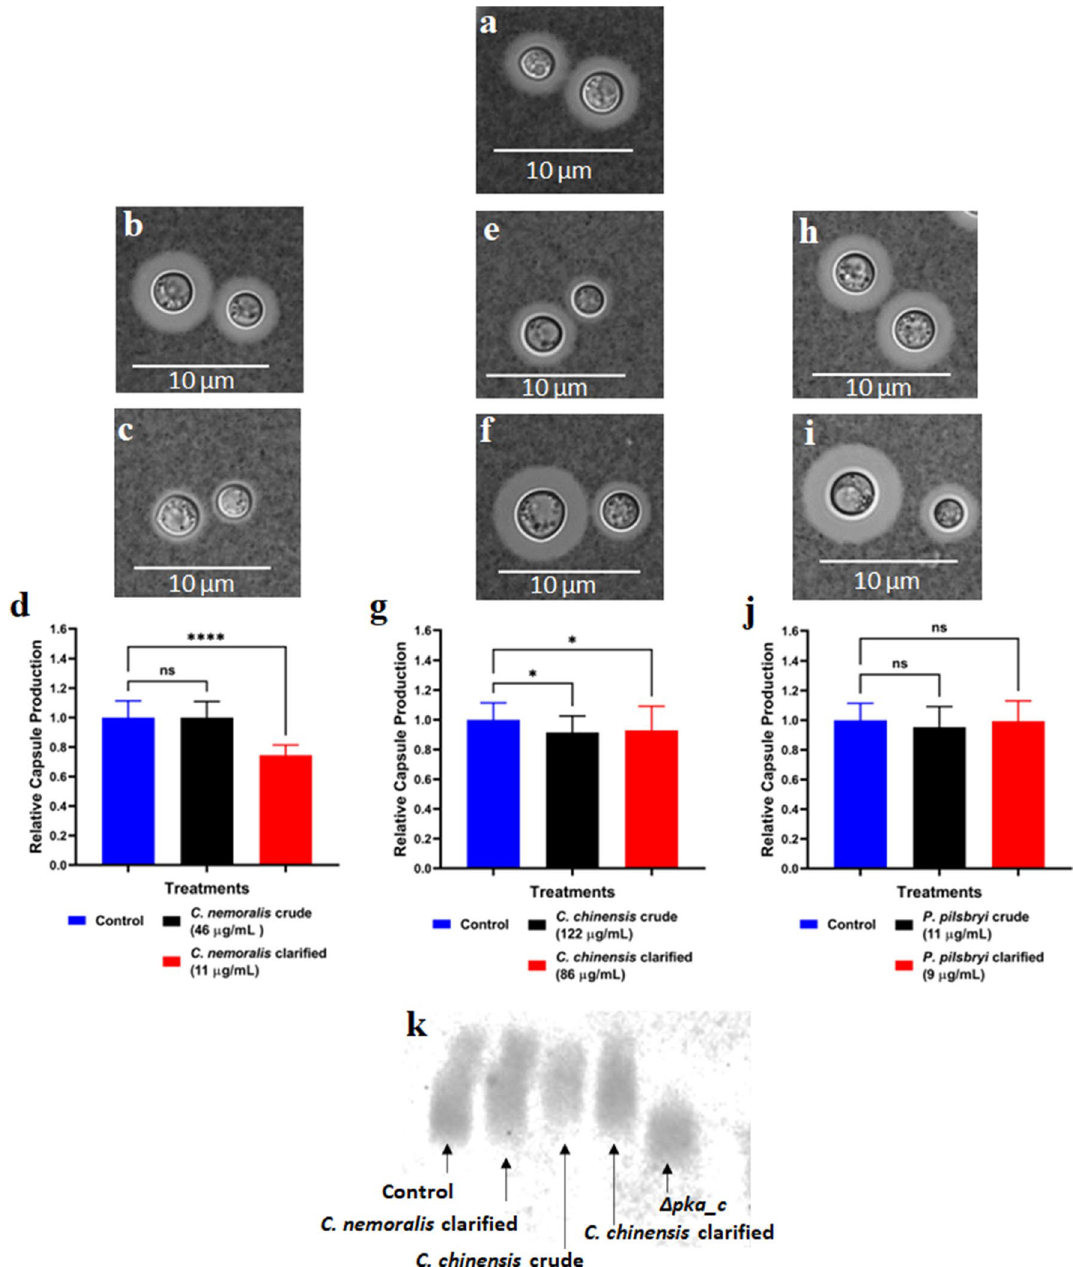
Figure 4. Representative capsule production of C. neoformans in presence of mollusk extracts at 37 °C. ( a ) Control (LIM and C. neoformans H99 only); ( b ) and ( c ) Effect of crude (46 µg/mL) and clarified (11 µg/mL) extracts from C. nemoralis , respectively; ( e ) and ( f ) Effect of crude (122 µg/mL) and clarified (86 µg/mL) extracts from C. chinensis , respectively and ( h ) and ( i ) Effect of crude (11 µg/mL) and clarified (9 µg/mL) extracts from P. pilsbryi , respectively. ( d ), ( g ) and ( j ) Statistical analysis between treatments and control. ( k ) Visualization of GXM released to the extracellular space. Control and treatments were performed using C. neoformans H99 cells and the acapsular C. neoformans strain, Δ pka, as a negative control. Cells were visualized using India ink (1:1 ratio) and a DIC microscope with an oil 63X objective. Error bars indicate standard deviation. Statistical analysis was performed using a one-way ANOVA and a Dunnett’s multiple comparison test with a p-value of 0.05. **p < 0.01; ***p < 0.001 and ****p < 0.0001. Approx. 50–60 cells were measured per treatment, with ratio of total cell (including capsule) to cell body presented. Experiment was performed in biological triplicate and technical duplicate. Figures were created using GraphPad Prism urease across the treatments at 30 °C and 37 °C (EDTA was used as a control) (Fig. 6d). We did not observe a noticeable reduction in urease production, indicating that extract treatment does not influence the associated secretory pathway of C. neoformans .